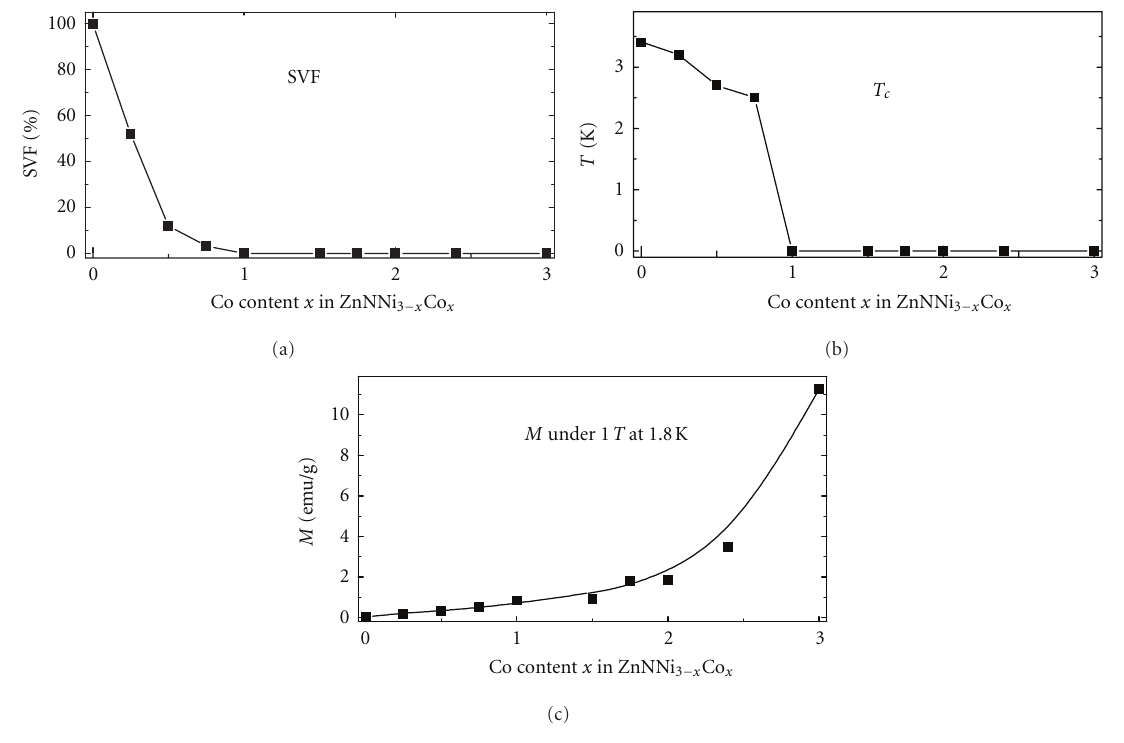
Figure 7: SVF (a), T c (b), and M (c) as a function of Co content, x